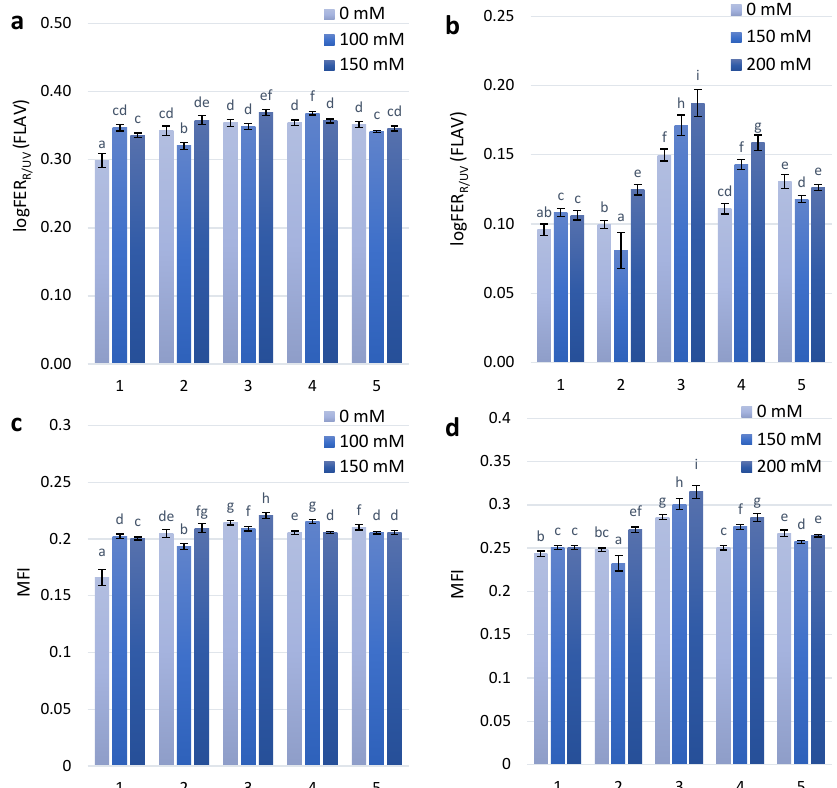
Figure 2. Flavonols accumulation (logFERR/UV-FLAV) in the leaves of investigated wheat plant genotypes exposed to salt stress during 30 days after seedlings ( a )—first stage of treatment; ( b )—second stage of treatment. MFI parameter in the leaves of investigated wheat plant genotypes exposed to salt stress during 30 days after seedlings ( c )—first stage of treatment; ( d )—second stage of treatment.The numbers shown individual cultivars of wheat: 1—Citrus yellow, 2—KM 53-14 Blue, 3—KM 178-14 purple, 4—Skorpion Blue aleurone, 5—PS Karkulka purple The columns represent the mean values ± S.E. for six replicates. Statistically significant differences among treatments at each time are indicated by different small letters (Duncam test, p < 0.05).